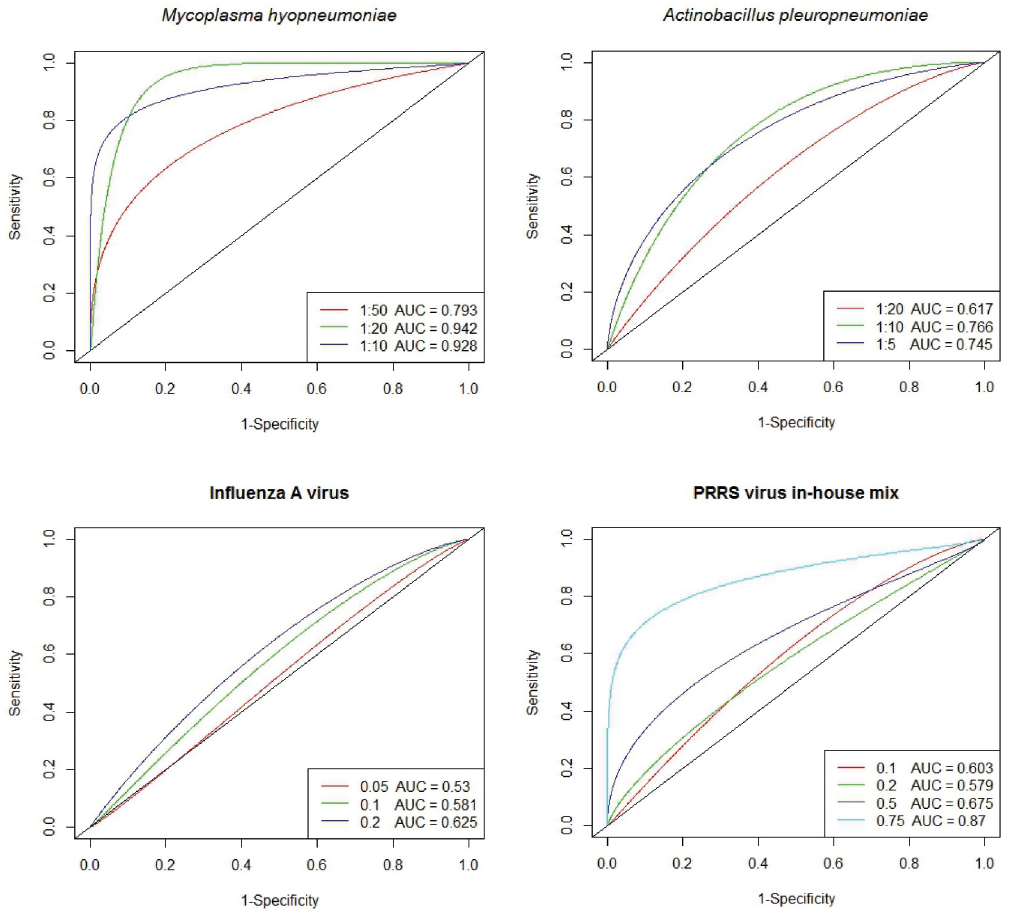
Fig 4. ROC plots of antigens for respiratory diseases spotted on the microarray. ELISA tests are used as reference tests. The number of positive and negative samples used to calculate the ROC analyses for the different antigen concentrations are shown in Table